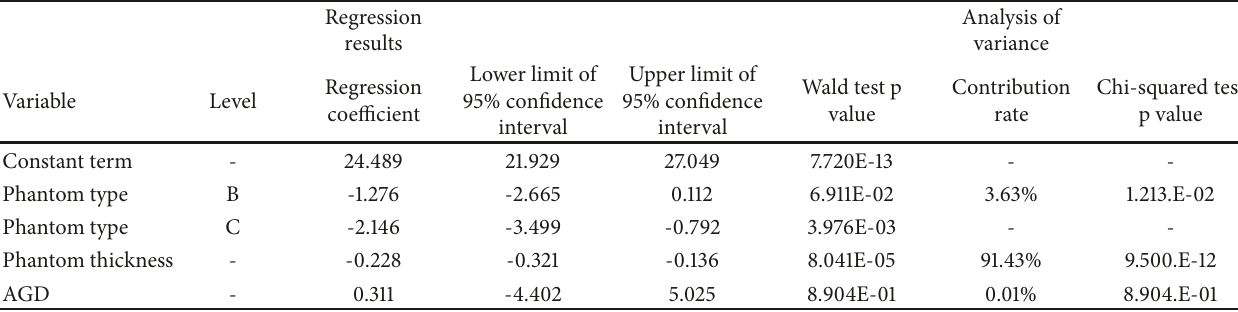
Table 6: Results of multivariate linear regression analysis using CNR as the objective variable and mammary gland ratio, AGD, and phantom thickness as the explanatory variables.